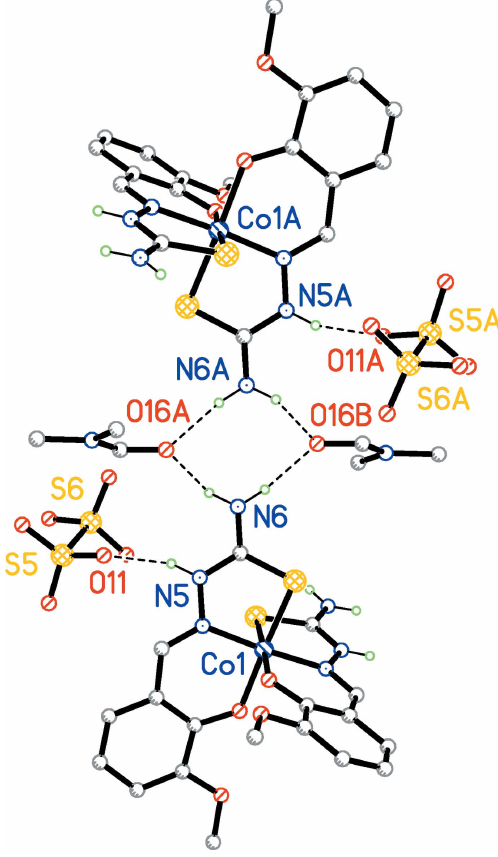
Figure 4 A fragment of the crystal packing of the title compound showing the double NH 2 (cid:2)(cid:2)(cid:2) O(DMF) (cid:2)(cid:2)(cid:2) H 2 N contacts that link the complex cations with two dimethyformamide molecules through bridging oxygen atoms. C-bound hydrogen atoms and rest of the solvent molecules are omitted for clarity. the ligands and the oxygen atoms of solvent molecules (O15, O16, O17, O18 of dimethylmethanamide and O19, O21 of methanol).